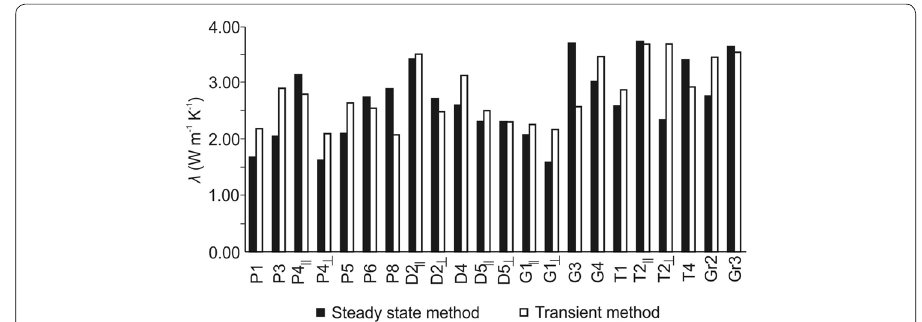
Fig. 5 Thermal conductivity evaluated by steady-state and transient methods for Kuujjuaq